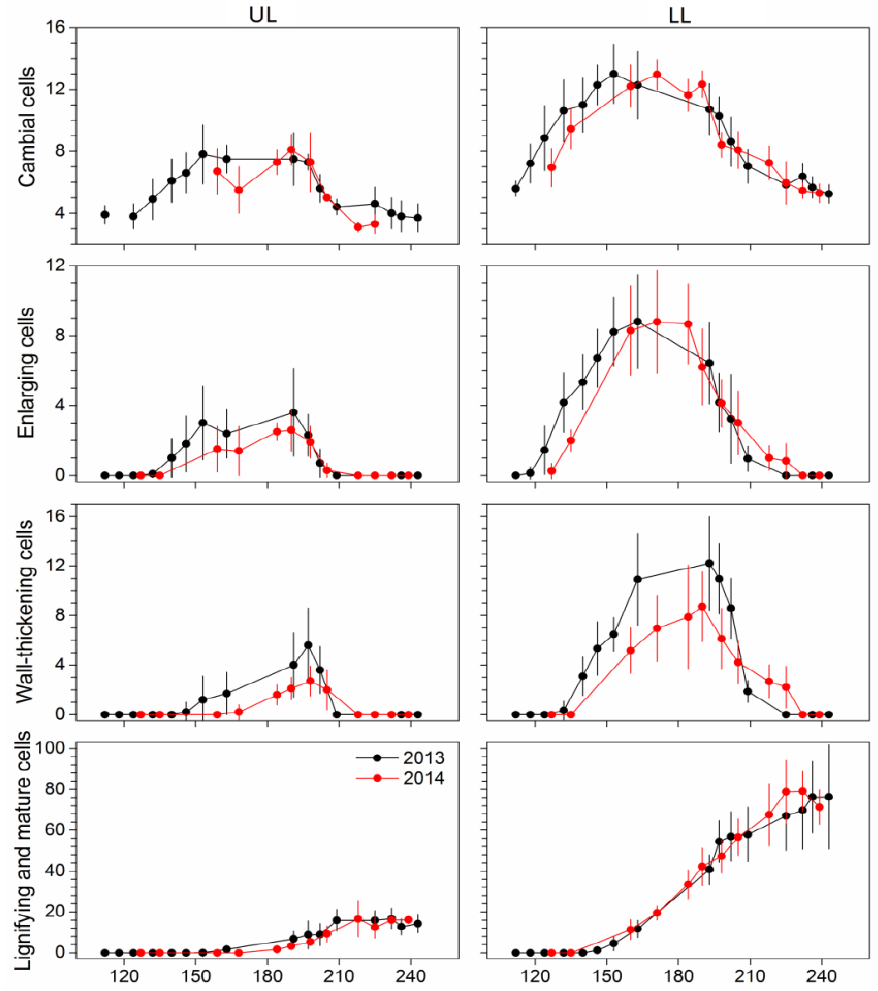
Figure 4. Number of cells during different xylogenesis phases at UL and LL during 2013 and 2014. Error bars indicate standard deviations for sampling trees per sampling date.